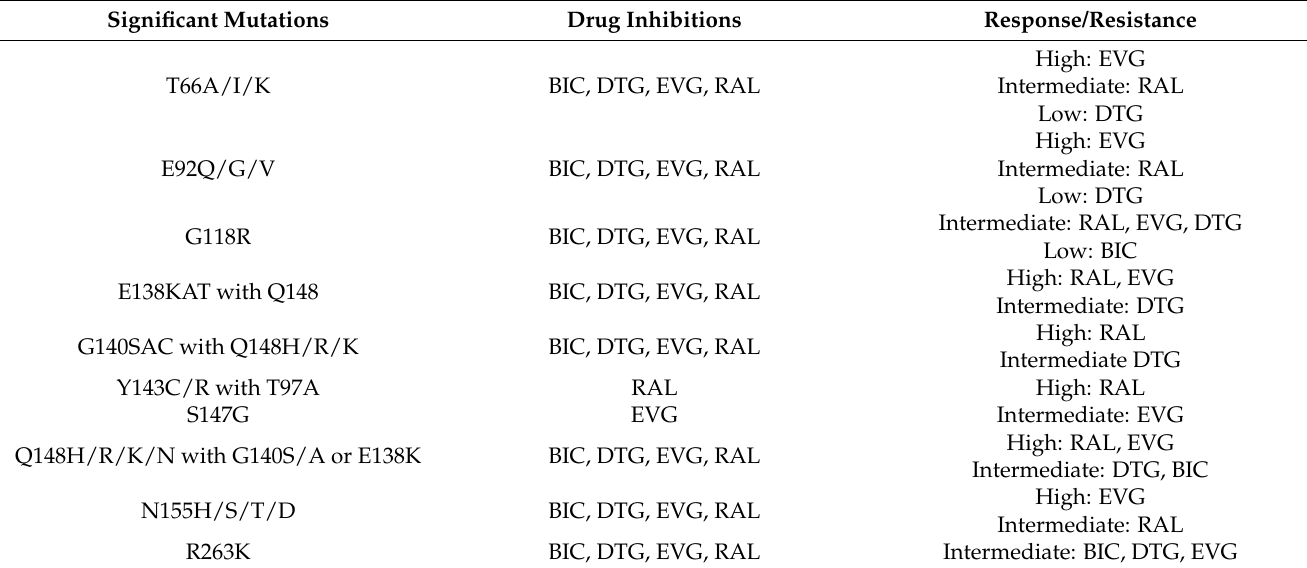
Table 6. Mutation patterns commonly found due to use of